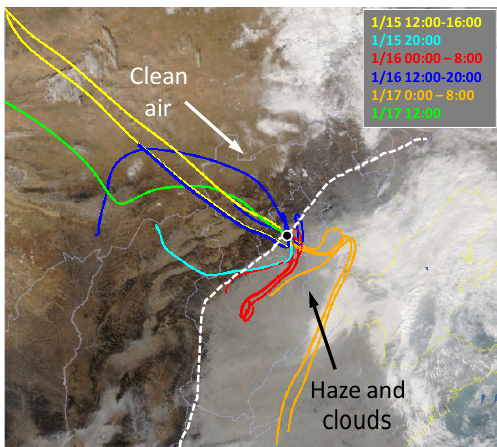
Figure 14. Two-day back-trajectories arriving at IAP, Beijing be- tween 12:00 on 15 January and 12:00 on 17 January. The back- trajectories at 100m height were calculated every 4h using NOAA HYSPLIT Trajectory Model (http://www.ready.noaa.gov) (Stein et al., 2015). The background picture shows the image from the Mod- erate Resolution Imaging Spectroradiometer (MODIS) instrument on board the Aqua Satellite on 16 January. The white dashed line is an approximate dividing line between clean and haze